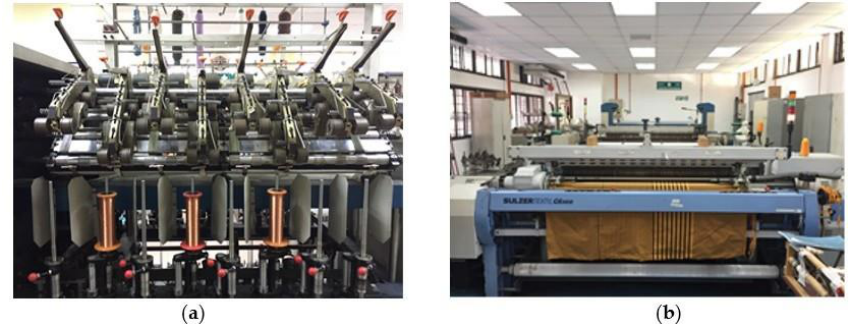
Figure 4. Electro-textile production process: ( a ) Spindle-spinning process for yarn formation; ( b ) Weaving process for e-textile formation.